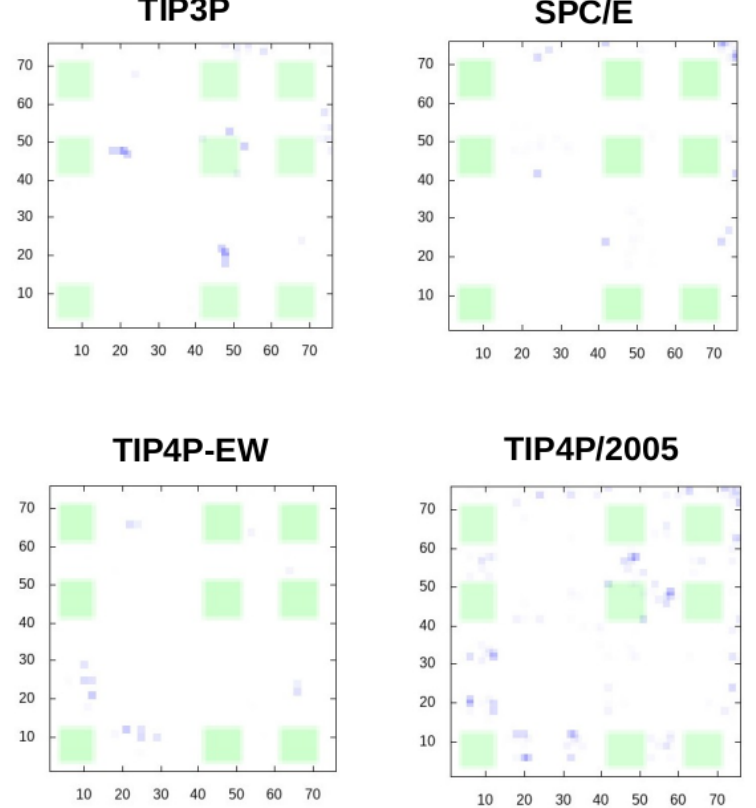
Figure 3. Intermolecular contact maps for the trajectories with the four water models. X,Y axes are the residue number along protein sequence. The regions where contacts are found in the NMR experiments are highlighted in